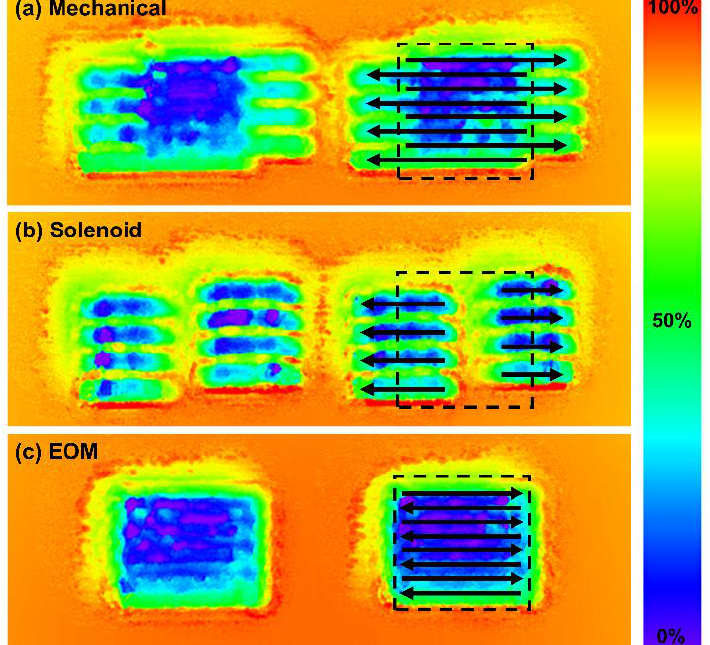
Figure 9. Heatmaps visualizing the topography of ablated microstructures on steel. As shown in the bar on the right side of the image, red colors correspond to high sections of material, and blue sections correspond to low sections. ( a ) Mechanical blade shutter. ( b ) Bistable rotary solenoid shutter. ( c ) EOM shutter.